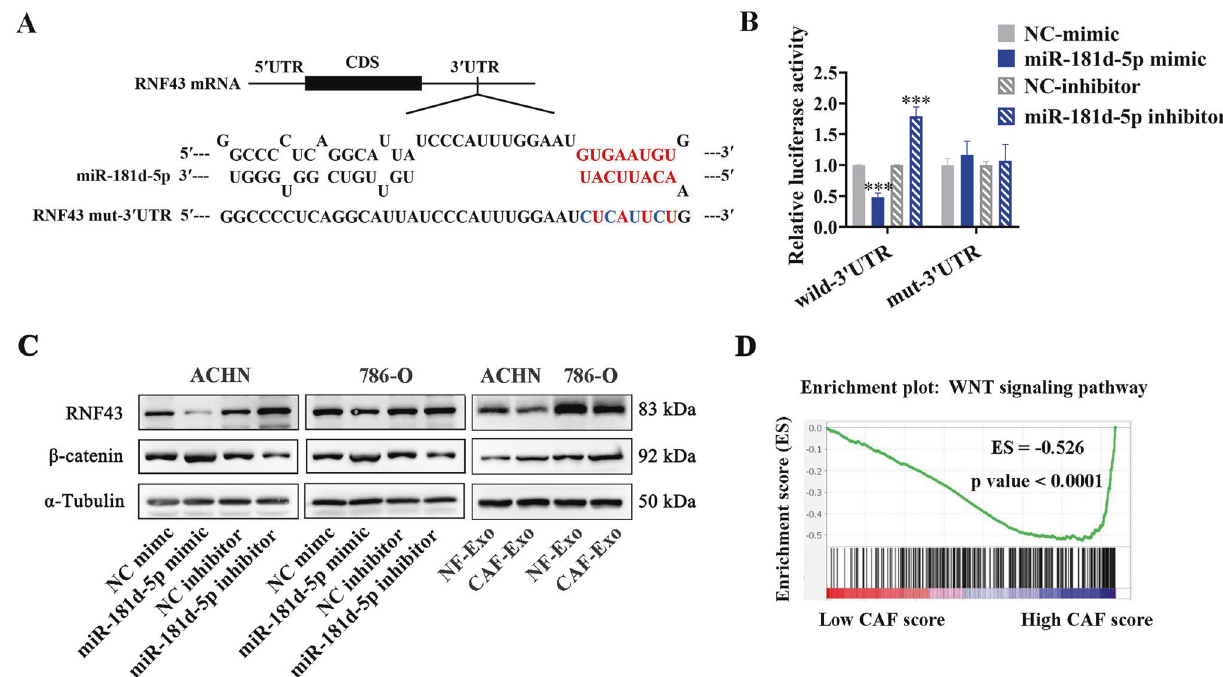
Fig. 7 RNF43 is a direct target of miR-181d-5p. A predictive interaction of miR-181d-5p in RNF43 mRNA 3 ′ -UTR by TargetScan and RNAhybrid, and mutation of the indicated nucleotides in seed sequences. B Dual-luciferase reporter assays of the effects of miR-181d-5p mimics and inhibitors on wild-3 ′ -UTR and mut-3 ′ -UTR in ACHN cells. C Western Blot analysis of RNF43 and β -catenin levels in ACHN and 786-O cells transfected with miR-181d-5p mimics, inhibitors, or corresponding controls, as well as in ACHN and 786-O cells pre-treated with NF-Exo or CAF-Exo. D Enrichment pro fi le of the WNT signaling pathway in high vs low CAF score RCC tumors using GSEA, (ES = -0.526, P < 0.0001). Cell experiment was repeated three times independently, P value between two groups was obtained by Unpaired t test. *** P <